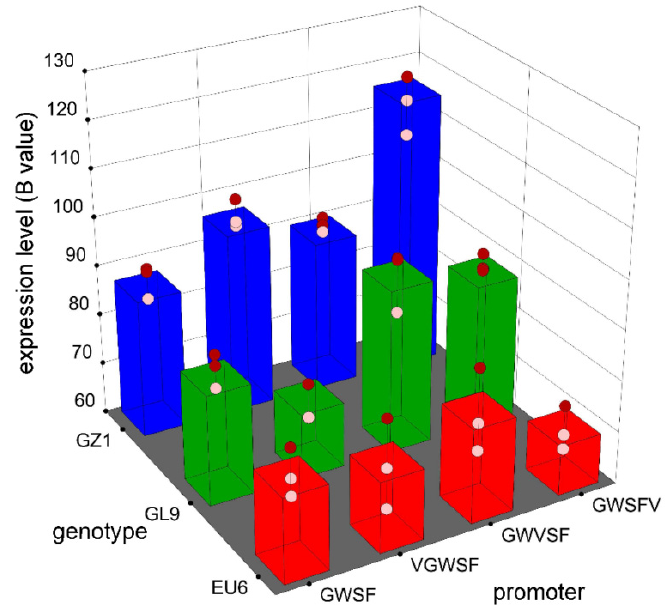
Figure 4. GUS gene expression in three eucalyptus genotypes from different promoters. Blue values of extracted RBG were measured by GUS histochemical staining from three eucalyptus leaves after three measurement replicates. According to the established two-factor full factorial model, B value (blue value) of the column in the figure reflects the predicted value from the model function. The red circles and light red circles in the figure are design points above the predicted value and below the predicted value, respectively. A factor consists of four promoters, namely GWSF, VGWSF, GWVSF, and GWSFV. B factor is a genotype factor, which is composed of three genotypes of GZ1, EU6, and GL9.